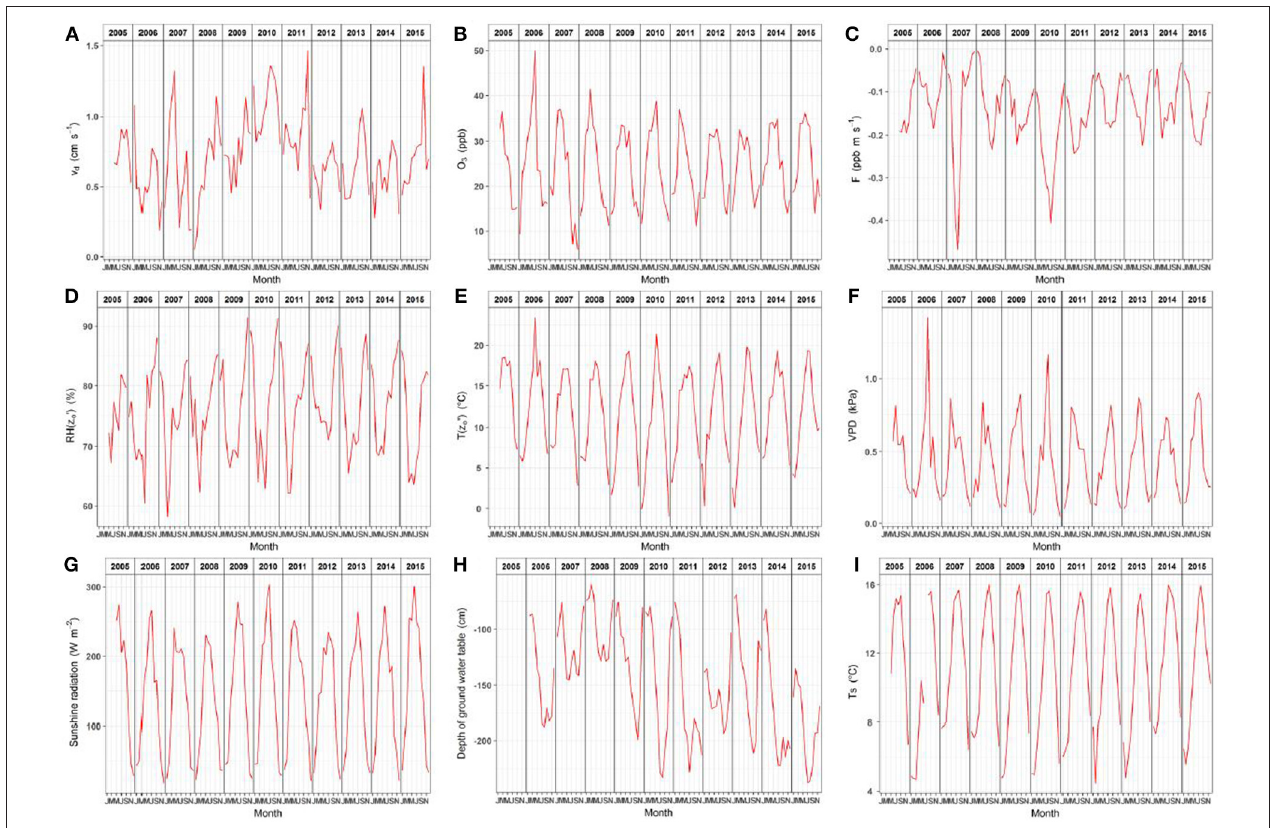
FIGURE 5 | Time series of the monthly (A) deposition velocity ( υ d ), (B) ozone mixing ratio (O 3 ), (C) ozone flux ( F ), (D) relative humidity at the leaf surface ( RH (z 0 ′ )), (E) temperature at the leaf surface ( T (z 0 ′ ), (F) vapor pressure deficit ( VPD ), (G) solar radiation, (H) depth of ground water table, (I) soil temperature ( T s ) over the entire period April 2005 to December